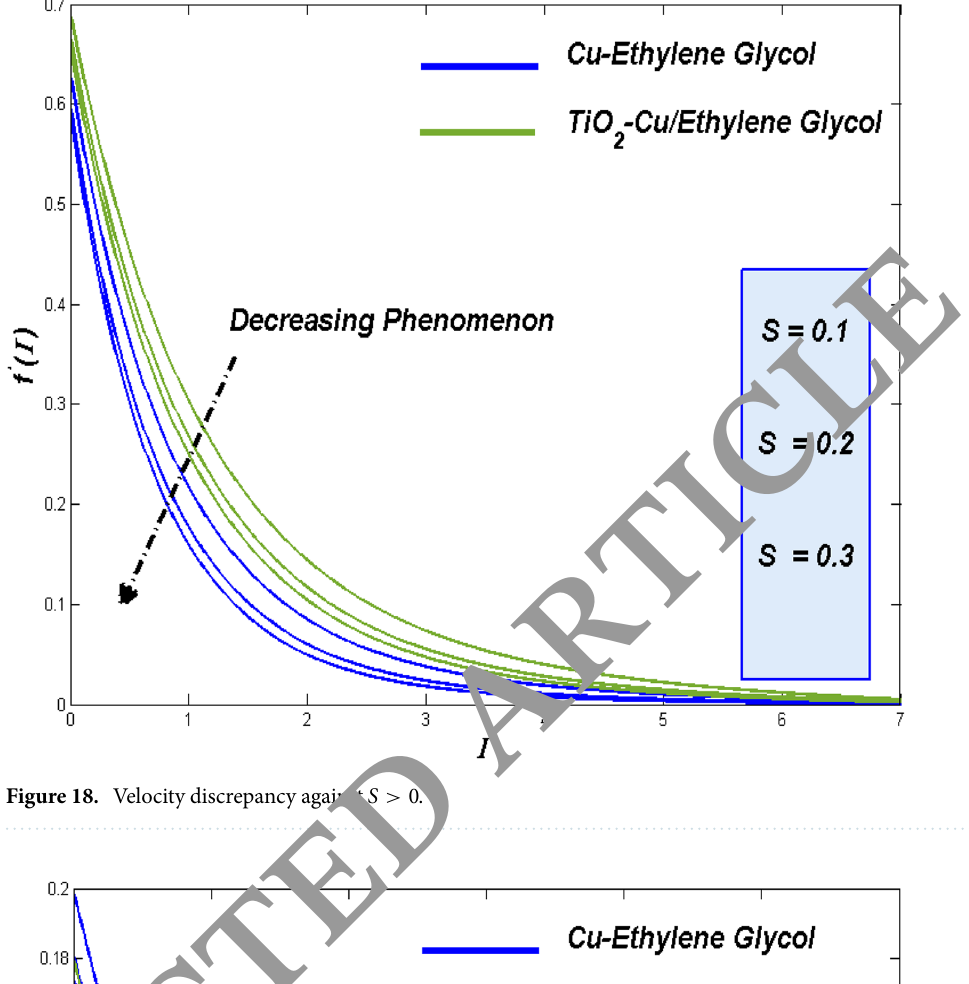
Figure 18. Velocity discrepancy against S > 0 .